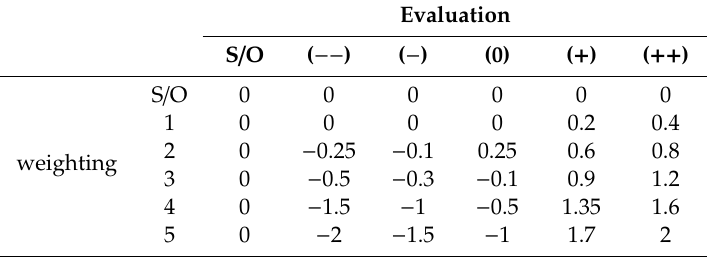
Table 2. Results matrix according to the evaluation and weighting of the questions in